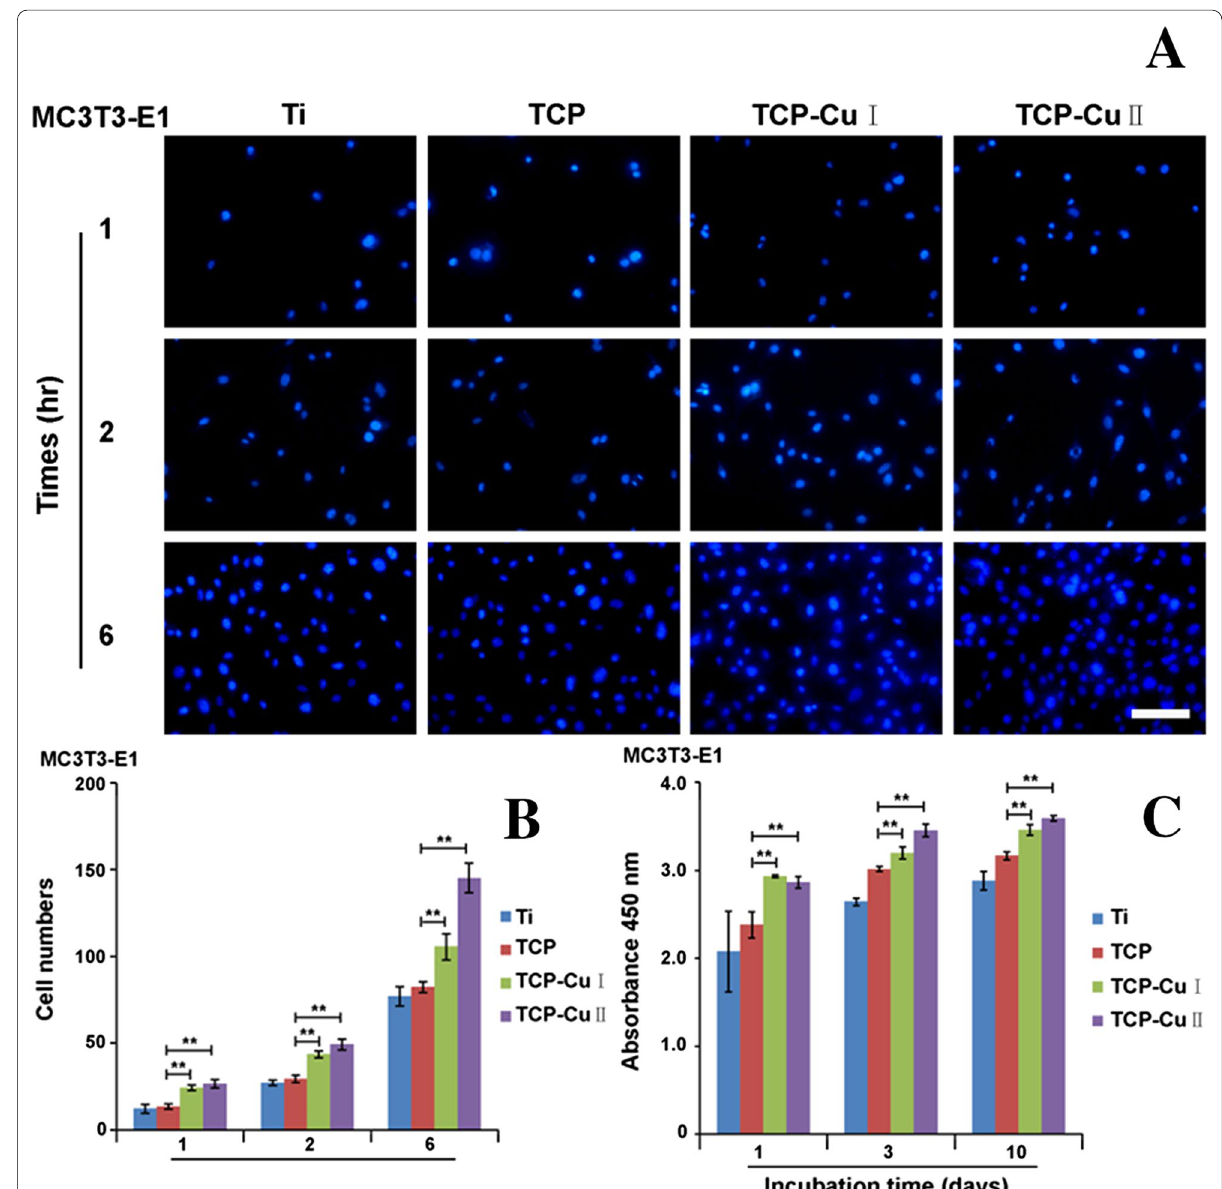
Fig. 6 Adhesion and proliferation of MC3T3‑E1 cells on the surfaces of different samples. a Cell adherent images at 1, 2 and 6 h after staining with DAPI, b bar chart of adherent cells and c bar chart of cell proliferation (Data are presented as mean